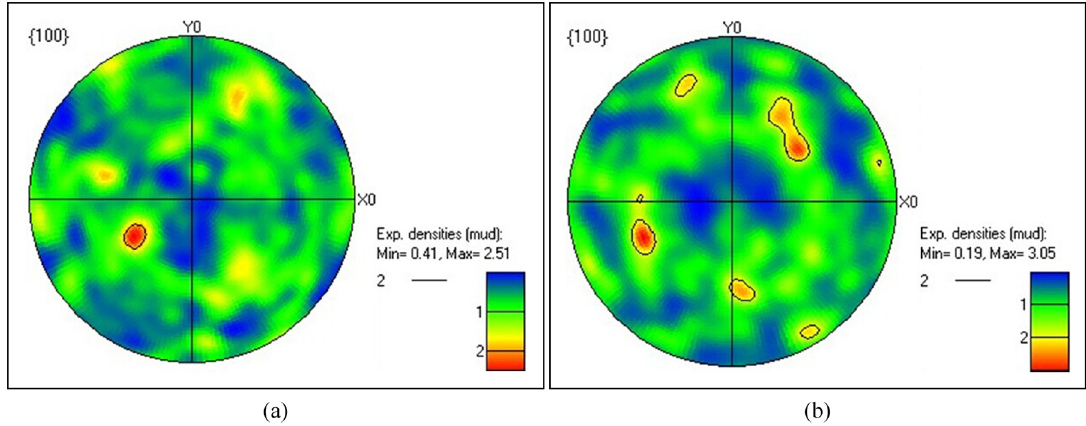
Figure 3. {100} pole figures of (a) the first copper sample and (b) the second copper sample.